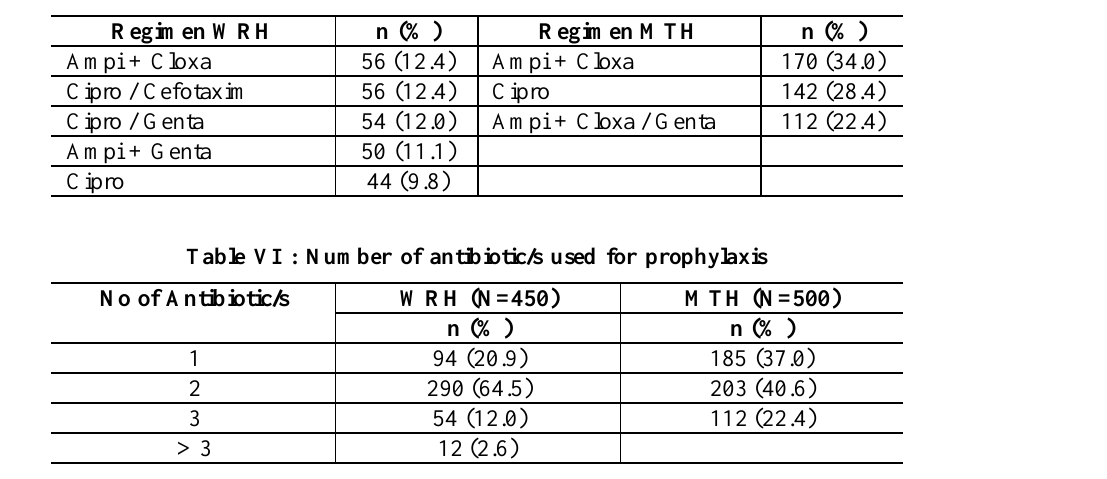
Table V : Commonly used regimen in two hospitals